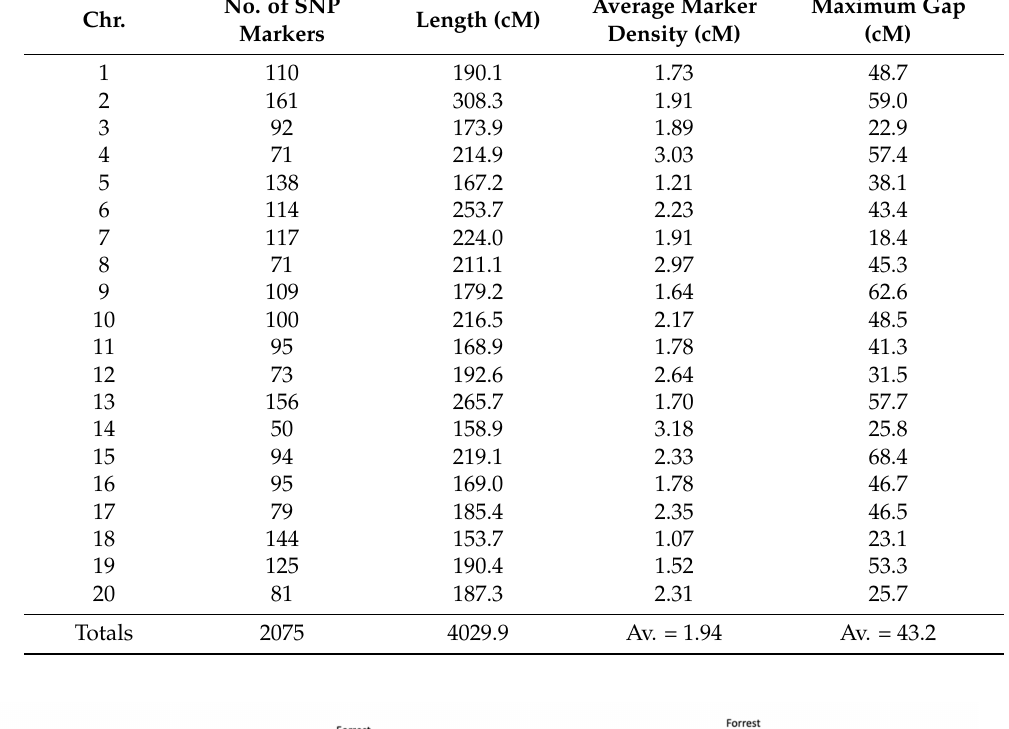
Table 1. Distribution of SNP markers and their properties on the Chrs. Of Forrest by Williams 82 recombinant inbred line (RIL) population ( n = 306).